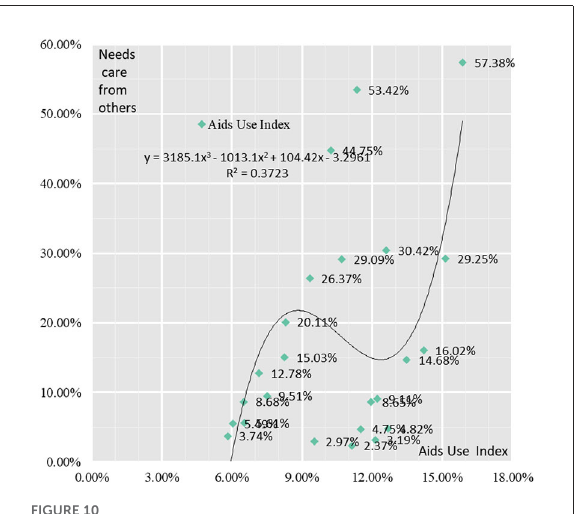
FIGURE10 Correlation analysis between healthcare needs of elderly people and aids